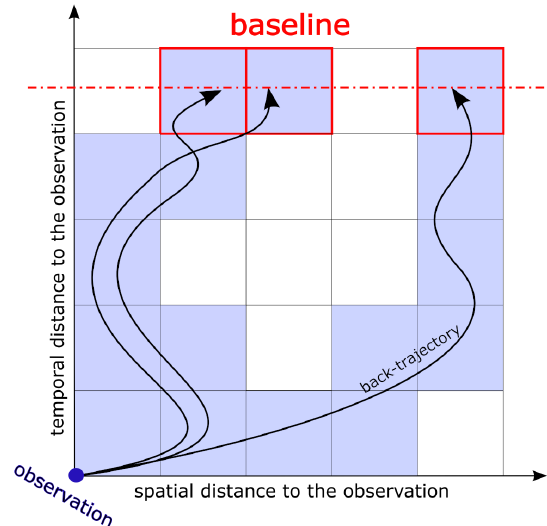
Figure 3. Simplified illustration of the global-distribution-based (GDB) method for baseline determination, where the backward sim- ulation is represented by three back trajectories released at the time and space of a particular observation. The spatiotemporal grid is simplified to two dimensions with a vertical time and a horizon- tal space axis. Grid cells that contribute to the modeled mixing ra- tio through emissions are shaded blue; termination grid cells where termination sensitivity is stored are marked with red rectangles; the termination point is illustrated by a dashed red horizontal